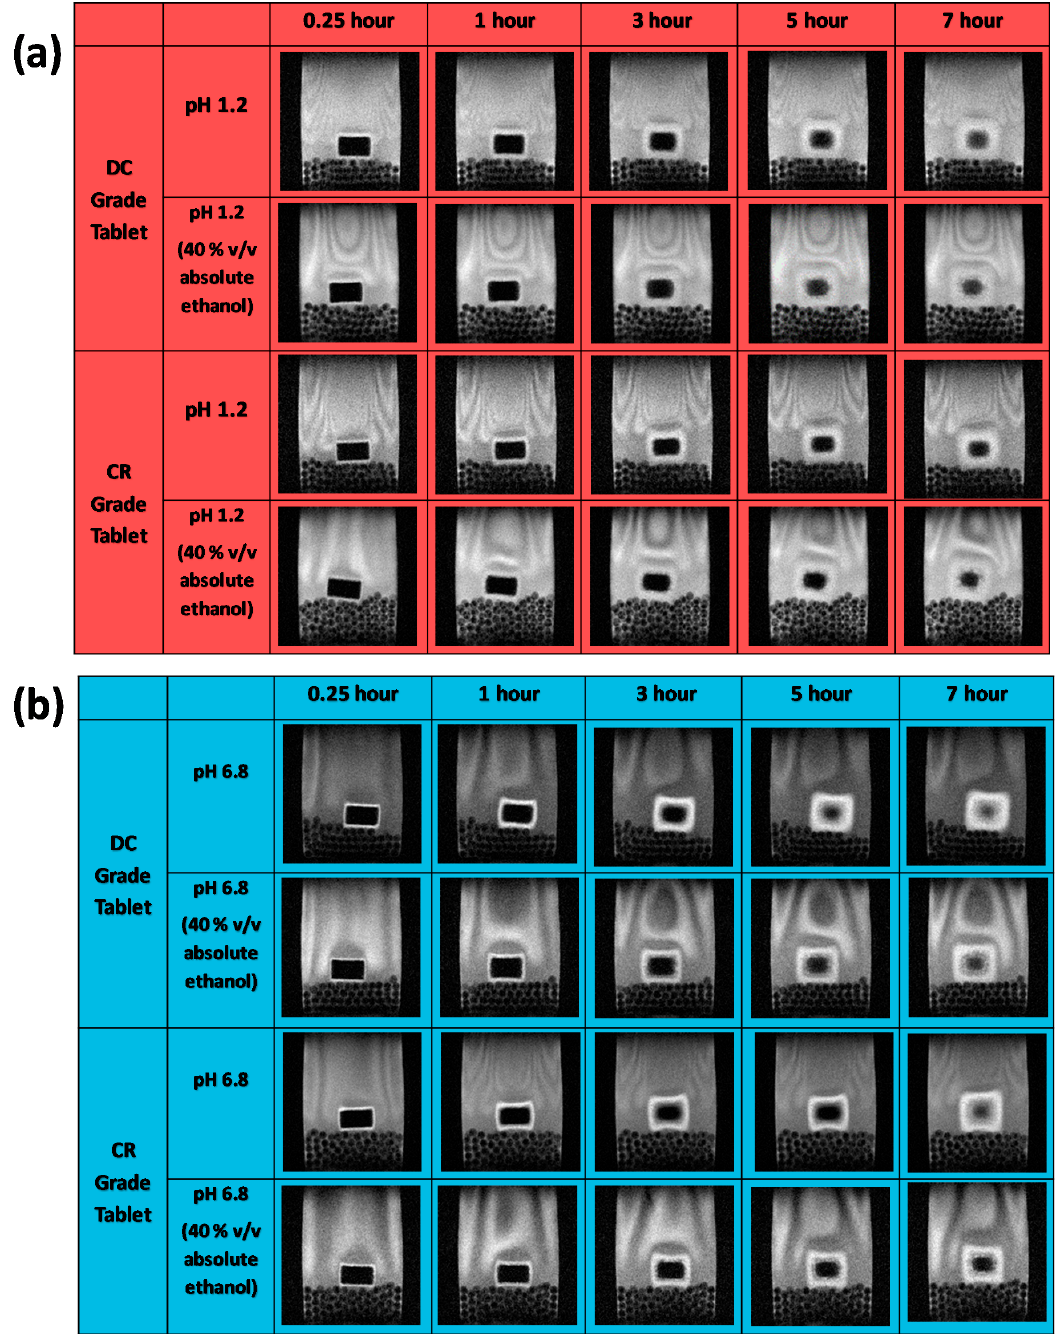
Figure 7. Magnetic resonance imaging of CR and DC formulations in ( a ) hydrochloric media with and without alcohol, ( b ) phosphate buffer media with and without alcohol.